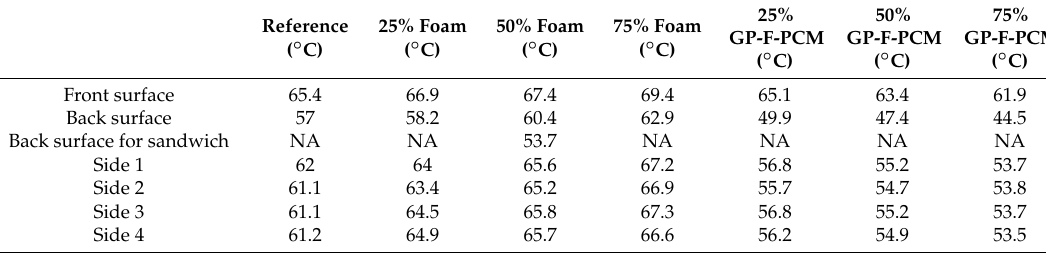
Table 2. Steady-state temperatures at different surfaces for all the geopolymer concrete